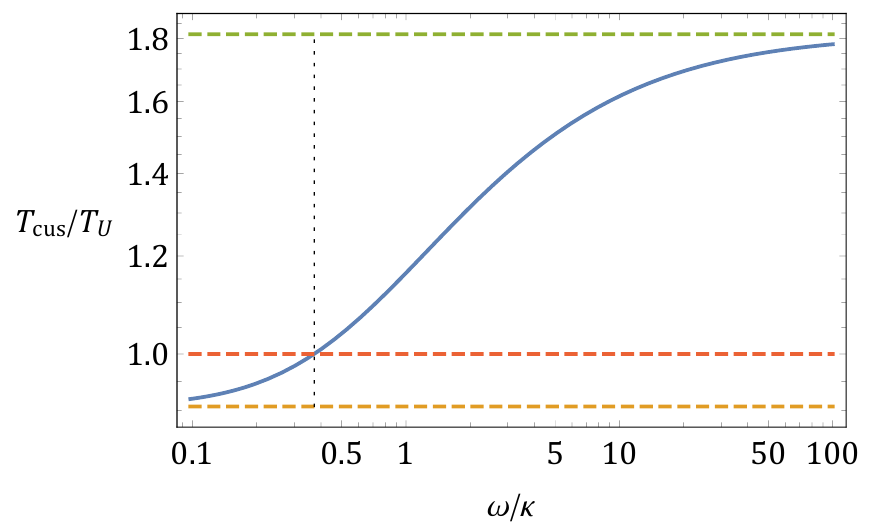
Figure 2 . E(cid:11)ective temperature along the Parator worldline. The coldest temperature p T cus (0) =T U = (cid:25)= (2 3) is indicated by a yellow dotted line. The hottest temperature T cus ( 1 ) =T U = p (cid:25)= 3 is indicated by a green dotted line. T cus = T U at characteristic frequency !=(cid:20) (cid:25) 0 :